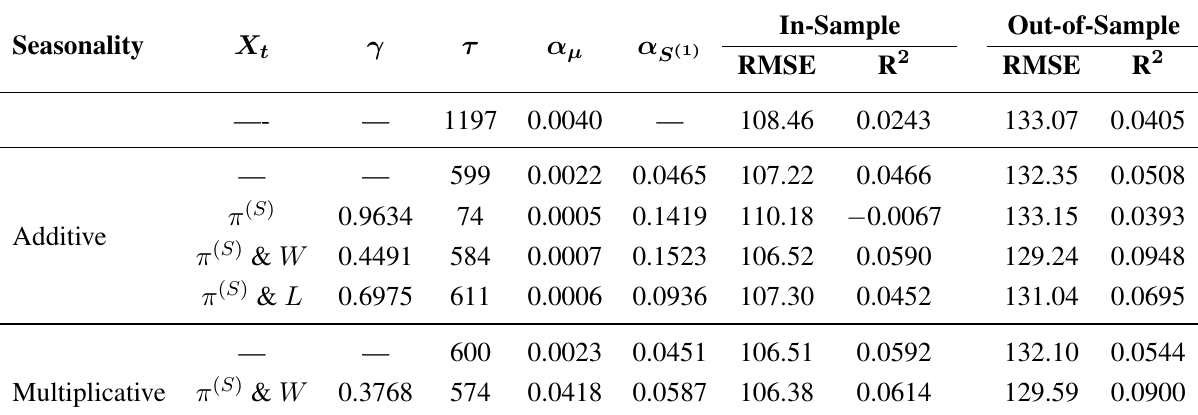
Table 5. The estimated model parameters along with performance measures for the best performing down-regulation penalty models. In-sample measures are for the training set, and out-of-sample ones relate to the test